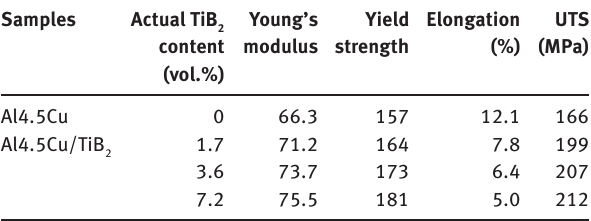
Table 1: Mechanical properties of TiB Al-4.5Cu alloy.